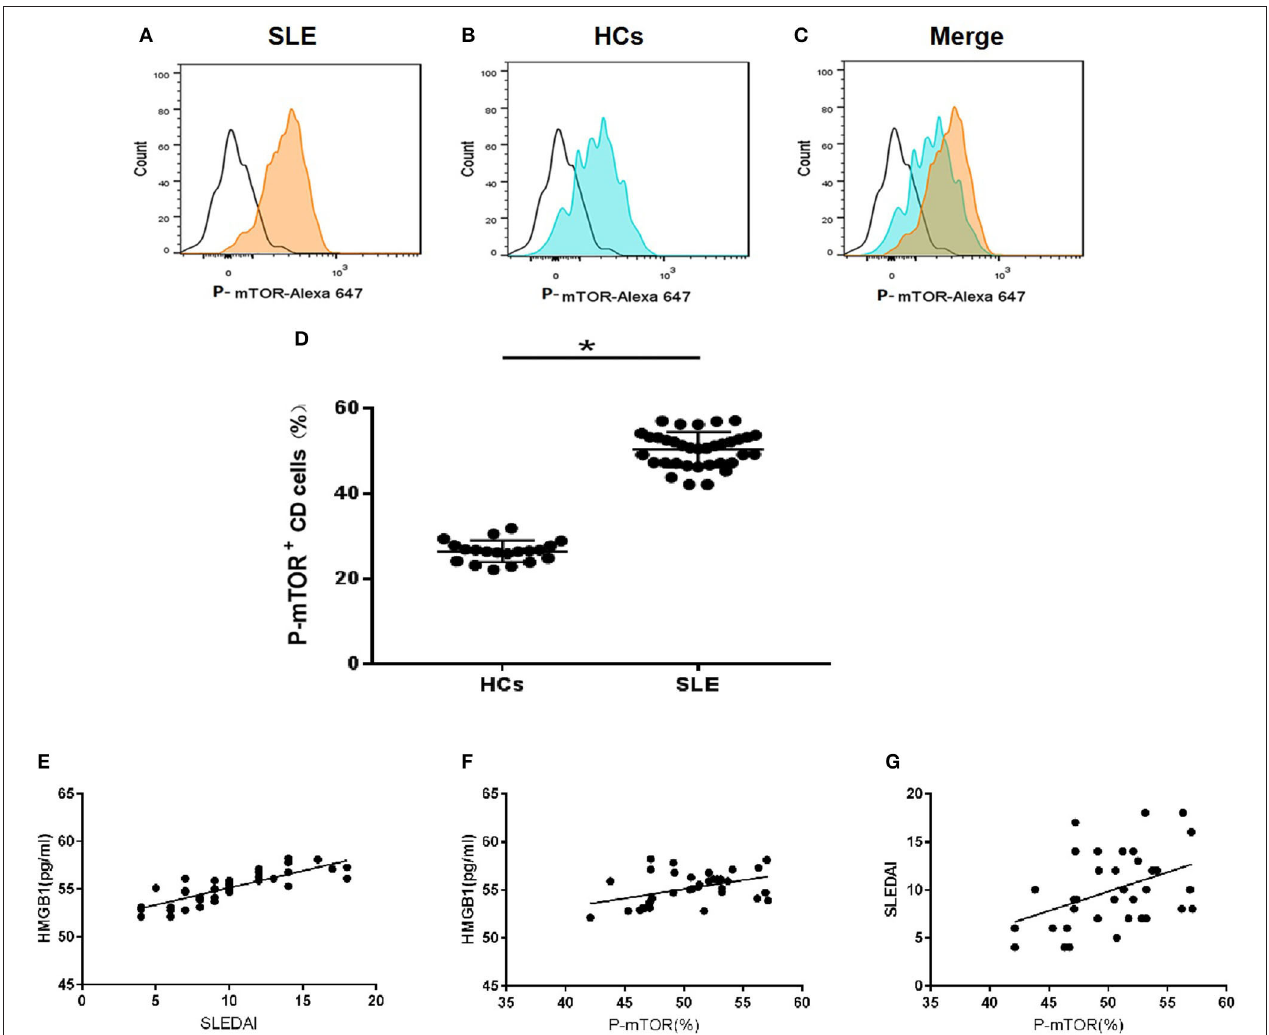
FIGURE 2 | HMGB1 was unregulated in SLE patients and positively correlated with levels of p-mTOR in mDCs. (A) The level of p-mTOR in DCs from SLE patients; (B) The level of p-mTOR in DCs from healthy controls (HCs); (C) The merged figure of A with B; (D) The level of p-mTOR in DCs from SLE patients was higher than HCs (50.35 ± 0.696% vs. 26.43 ± 0.565%, P = 0.027); * P < 0.05. (E) The correlation between serum HMGB1 concentrations and SLE disease activity index score (SLEDAI) in SLE patients. In peripheral blood, HMGB1 levels were positively correlated with SLEDAI scores ( r = 0.817, p < 0.001). (F) The correlation between the SLEDAI and p-mTOR in mDCs in peripheral blood of SLE patients. Levels of p-mTOR in mDCs were positively correlated with the SLEDAI ( r = 0.417, p < 0.0128). (G) The correlation between the levels of HMGB1 and p-mTOR in mDCs in peripheral blood of SLE patients. Levels of p-mTOR in mDCs positively correlated with the levels of HMGB1 in peripheral blood ( r = 0.446, p <